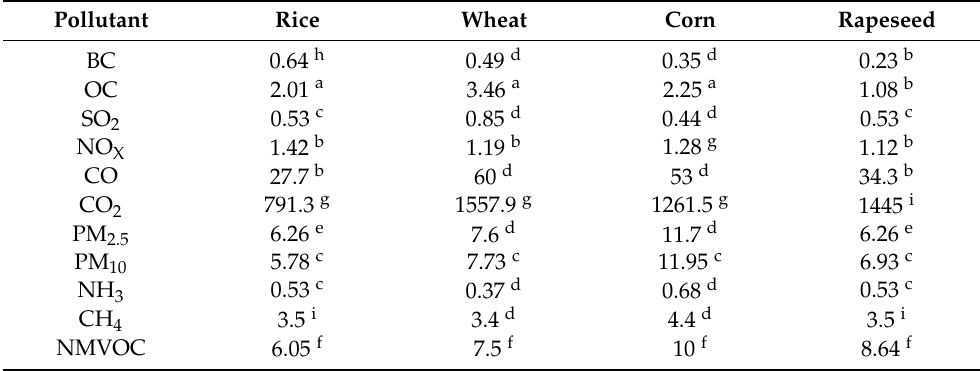
Table 4. Emission factors for crop residue open burning (g/kg). Pollutant Rice Wheat Corn